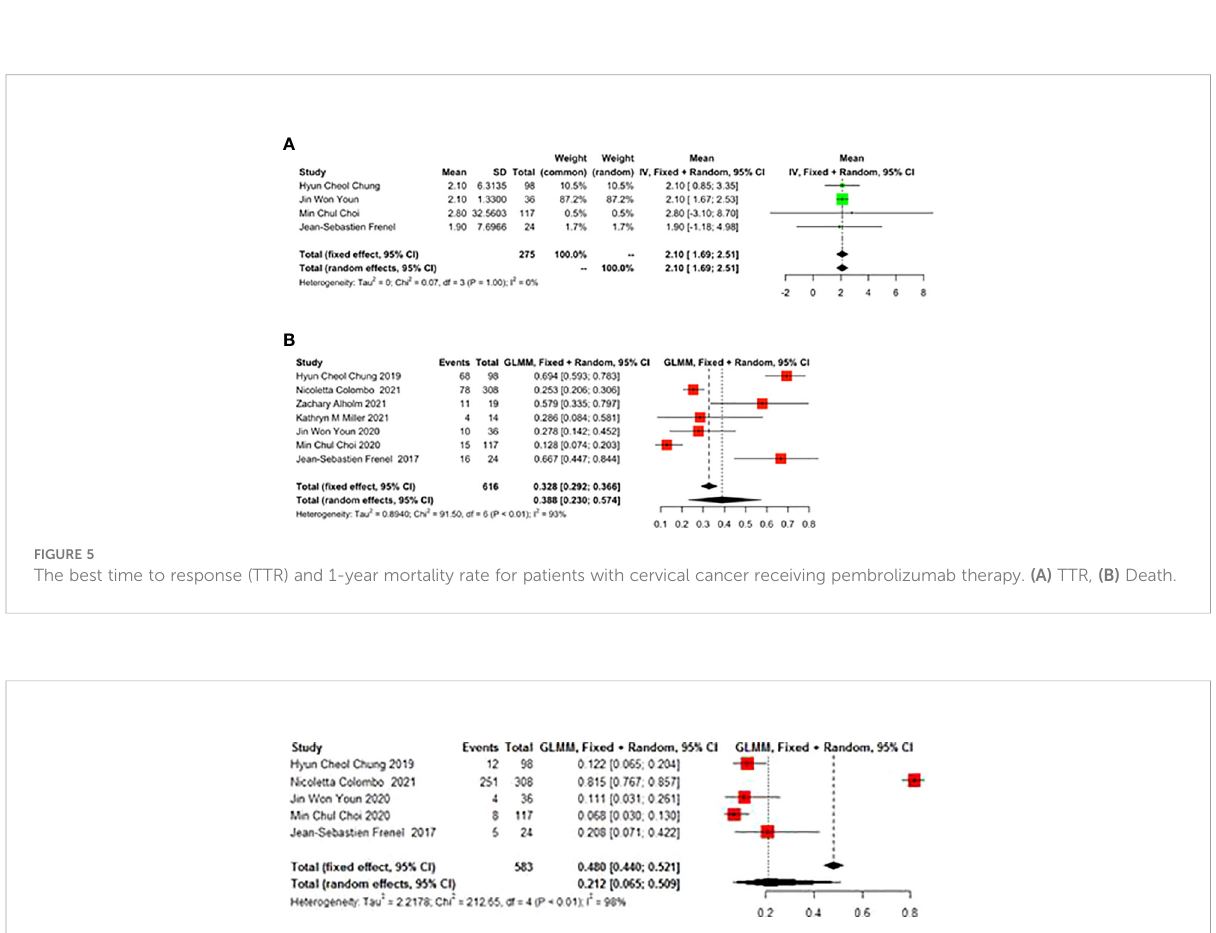
FIGURE 6 Adverse events (AE) for patients with cervical cancer receiving pembrolizumab